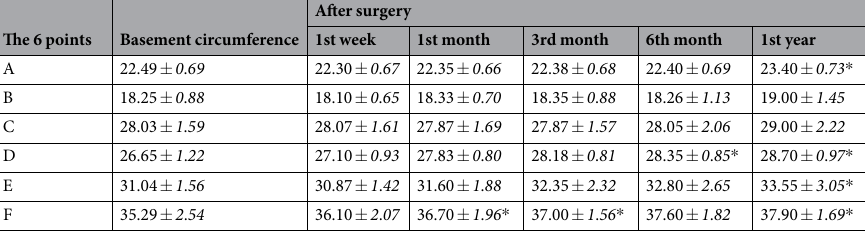
Table 2. The circumference of the affected upper limb after physiotherapy ( x ± s, cm). Abbreviations: (A) The part of the hand between the thumb and the index finger; (B) wrist; (C) the median of the forearm; (D) elbow through olecranon; (E) the median of the upper arm; (F) the root of the upper arm. * p < 0.05, based on a paired t-test.